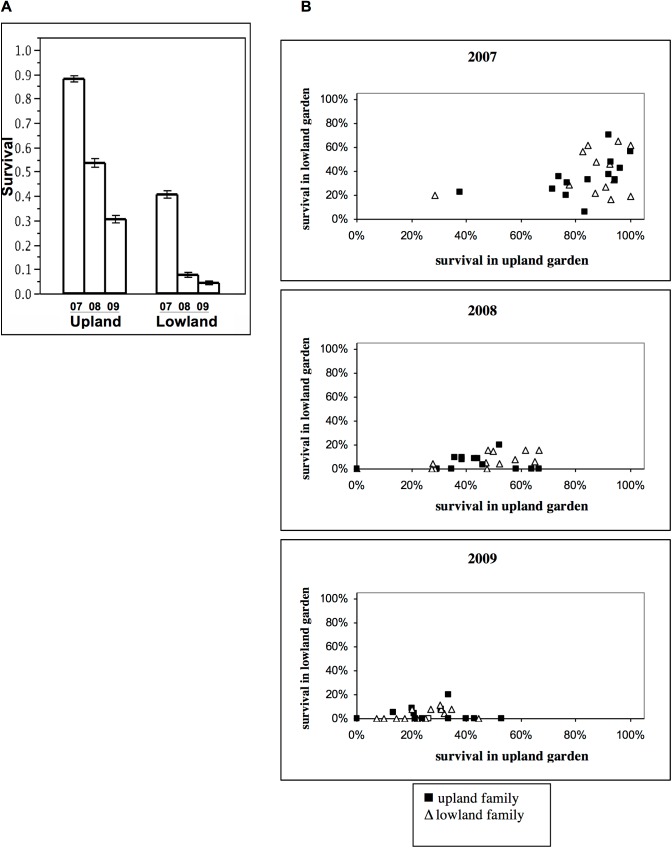
Average seedling survival in upland and lowland gardens.A) January 2007, January 2008, and January 2009. Error bars are standard errors. B) Upland families are solid shapes and lowland families are open.